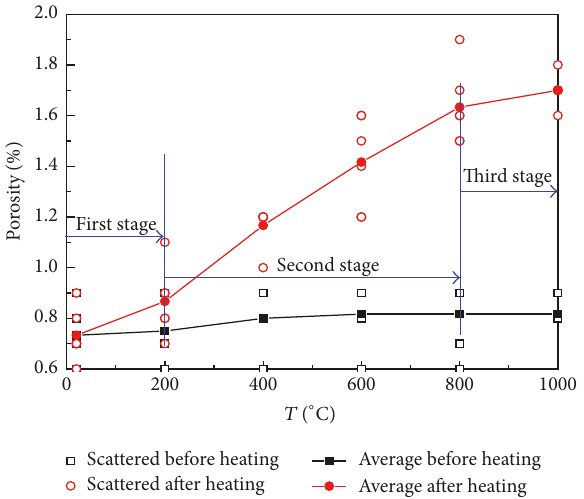
Figure 3: Variation of porosity versus temperature of sandstone.